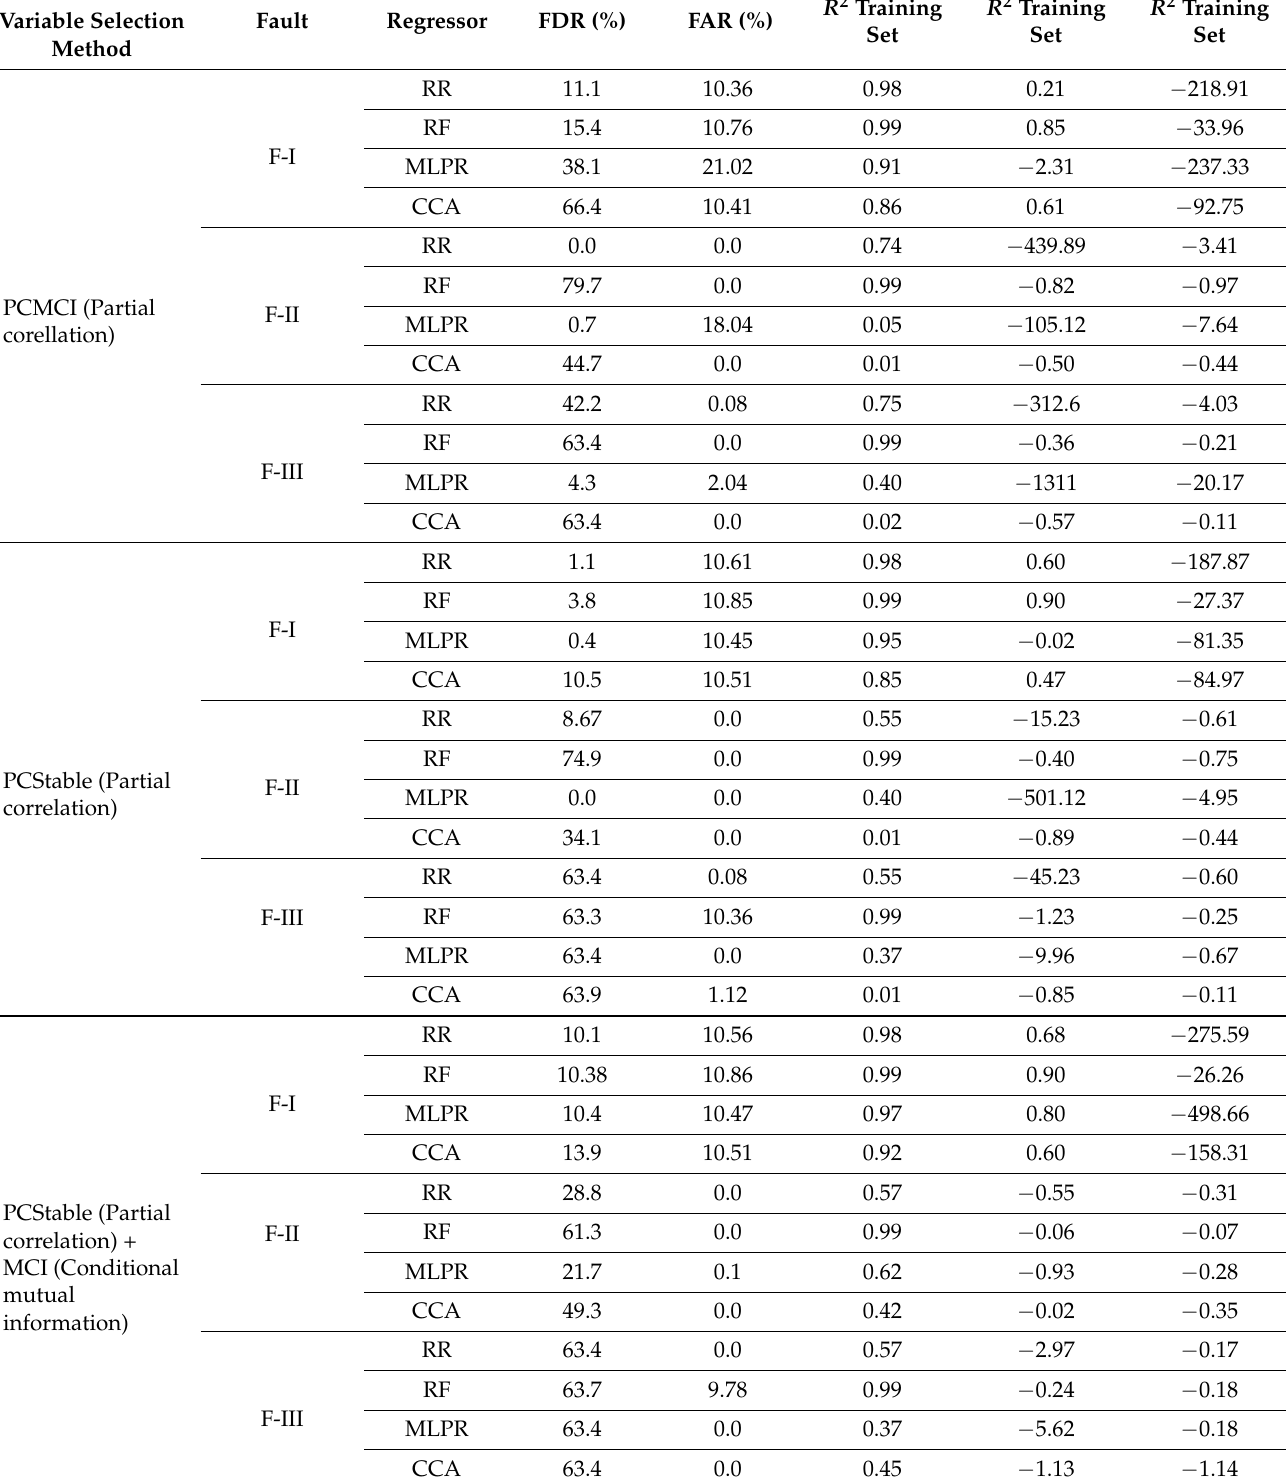
Table 10. Performance when causality methods were used for variable selection analysis of the industrial data. Variable